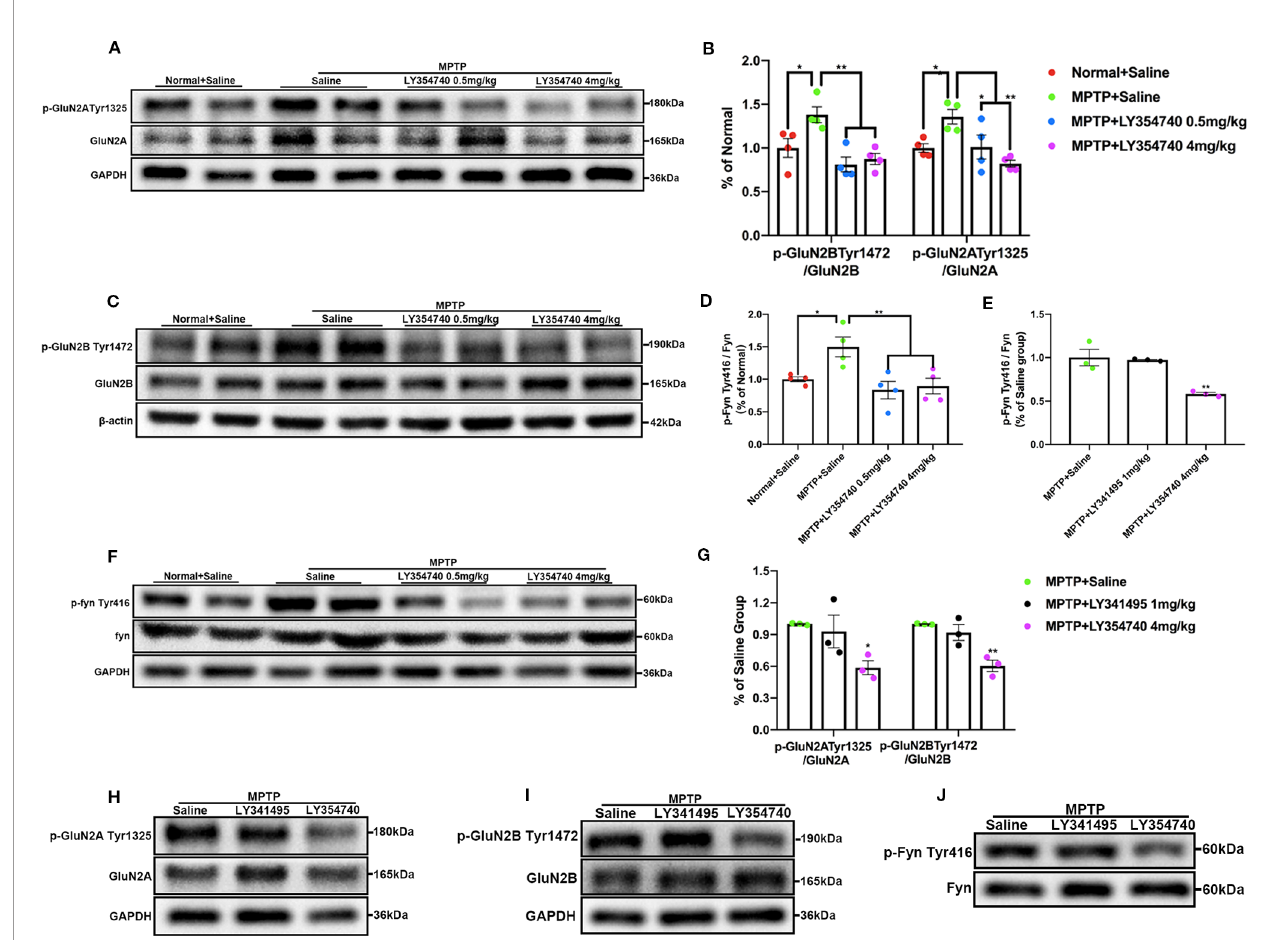
FIGURE 7 | mGlu 2/3 receptor ligands regulate expression of phosphorylation of Fyn/N-methyl-D-aspartate receptors (NMDAR) in acute 1-methyl-4-phenyl-1,2,3,6- tetrahydropyridine (MPTP) mice models. Immunoblots and relevant histograms show expression of phosphorylated NMDAR subunit GluN2A at Tyr1325 (A, B), GluN2B at Tyr1472 (B, C), Fyn at Tyr416 (D, F) in substantia nigra (SN) of acute MPTP-treated mice with different doses of LY354740. The band intensity of particular target proteins was normalized to GluN2A, GluN2B or Fyn levels. *p < 0.05, **p < 0.01. N = 4. Western blots represent the expression of phosphorylated NMDAR subunit GluN2A at Tyr1325 (G, H), GluN2B at Tyr1472 (G, I) and Fyn at Tyr416 (E, J) in acute MPTP-treated mice with saline, LY341495 or LY354740. The band intensity of particular target proteins was normalized to GluN2A, GluN2B or Fyn levels. *p < 0.05, **p < 0.01 vs. the other two groups. N = 3. Data in (B, D) were expressed as % of the normal + saline group, and data in (E, G) were expressed as % of the MPTP + saline group. Error bars represent